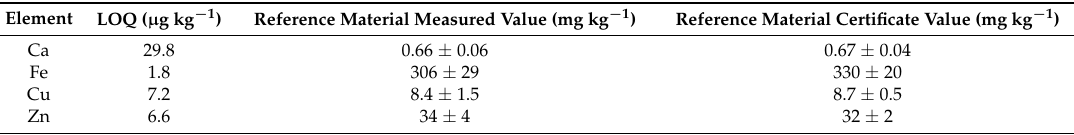
Table 2. ICP-MS precision and accuracy of the